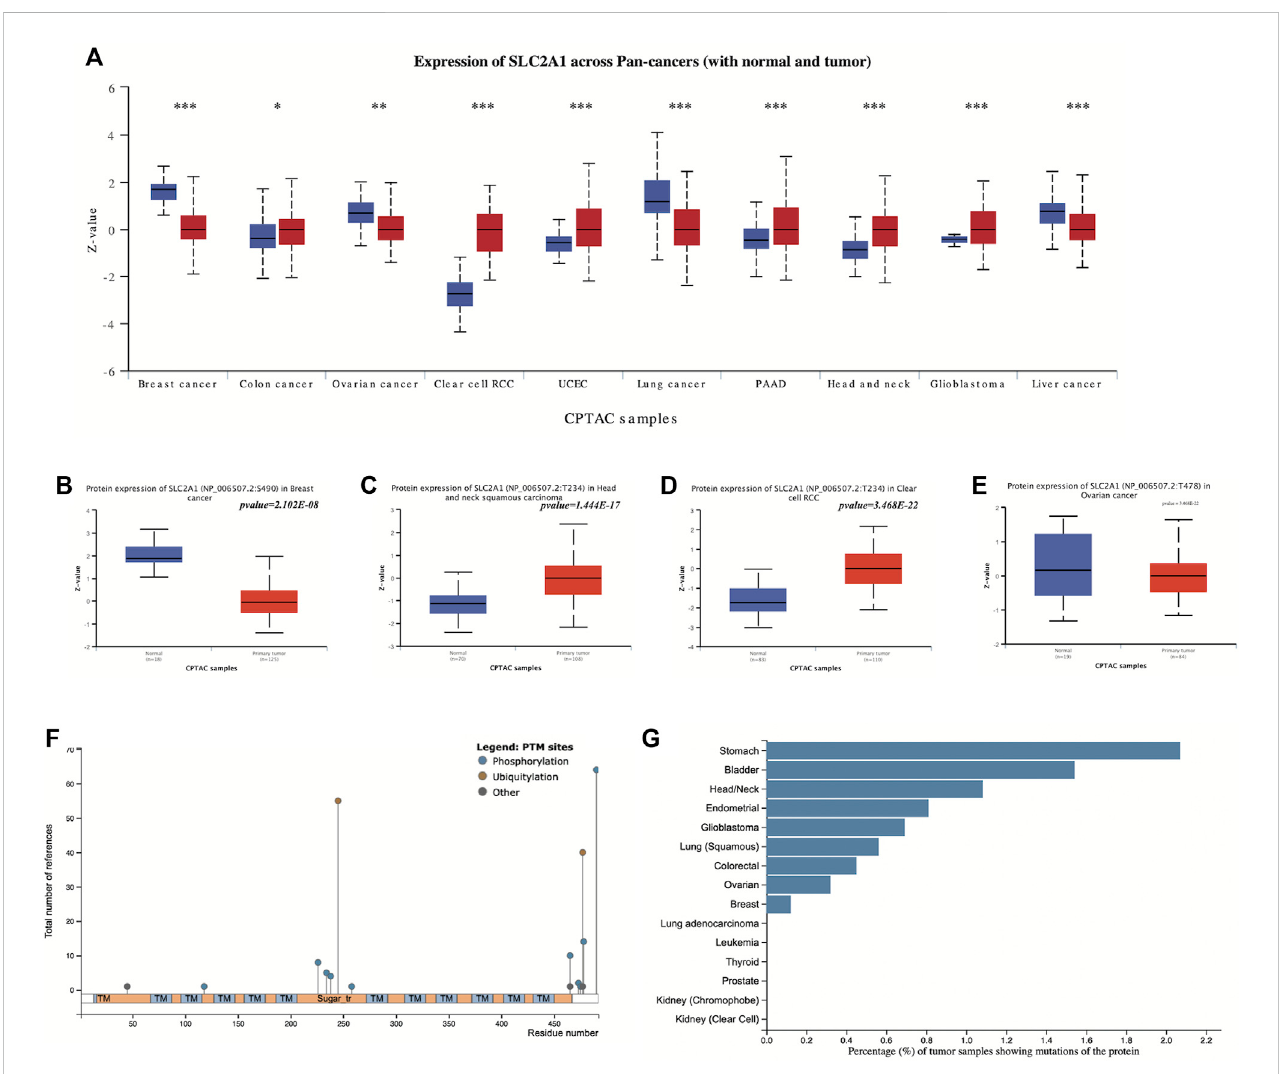
FIGURE 5 Proteomic evaluation of SLC2A1 in pan-cancer (A) The protein expression levels of SLC2A1 in normal and primary tumor tissues were compared in UALCAN using CPTAC data (B – E) Phosphorylation of SLC2A1 in tumor and normal tissues according to UALCAN (F) The type of SLC2A1 PTM sites and their numberofreferencesinresearchaccordingtothePhosphpSitePlusdatabase (G) FrequencyofSLC2A1proteinalterationsindifferenttumorsaccordingtothe PhosphpSitePlus database. PTM, post-translational modi fi cation; * p < 0.05; ** p < 0.01; *** p <